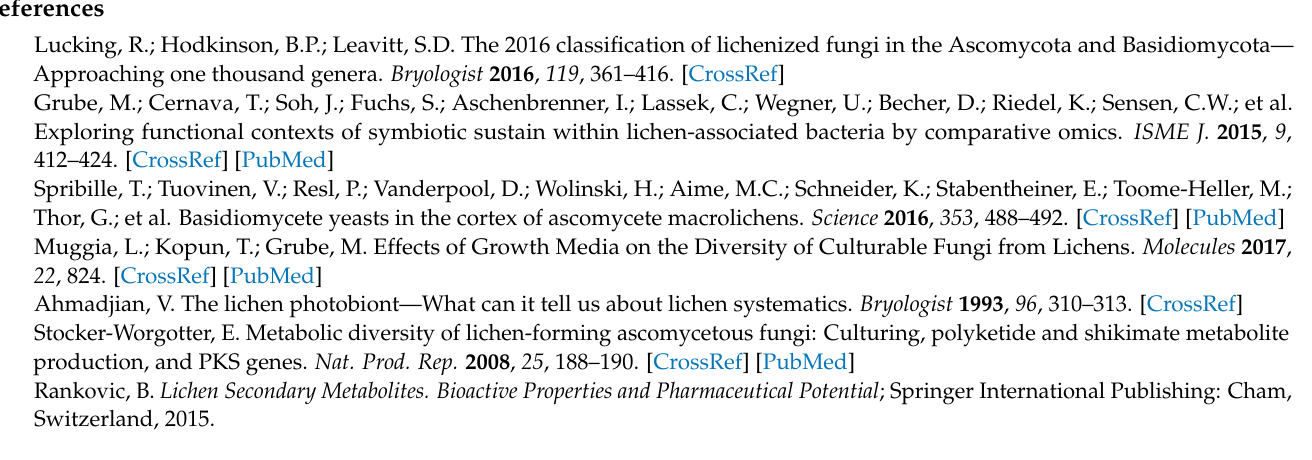
evernic acid; Figure S7. 1 H, 13 C-HSQC NMR spectrum (600 MHz, 150 MHz, DMSO-d 6 ) of evernic acid; Figure S8. 1 H, 13 C-HMBC NMR spectrum (600 MHz, 150 MHz, DMSO-d 6 ) of evernic acid; Figure S9. 1 H NMR spectrum (600 MHz, DMSO-d 6 ) of gyrophoric acid.; Figure S10. 13 C NMR spectrum (150 MHz, DMSO-d 6 ) of gyrophoric acid; Figure S11. 1 H, 13 C-HSQC NMR spectrum (600 MHz, 150 MHz, DMSO-d 6 ) of gyrophoric acid; Figure S12. 1 H, 13 C-HMBC NMR spectrum (600 MHz, 150 MHz, DMSO-d 6 ) of gyrophoric acid; Figure S13. 1 H NMR spectrum (600 MHz, CD 3 OD-d 4 ) of physodic acid; Figure S14. 13 C NMR spectrum (150 MHz, CD 3 OD-d 4 ) of physodic acid; Figure S15. 1 H, 13 C-HSQC NMR spectrum (600 MHz, 150 MHz, CD 3 OD-d 4 ) of physodic acid; Figure S16. 1 H, 13 C-HMBC NMR spectrum (600 MHz, 150 MHz, CD 3 OD-d 4 ) of physodic acid; Figure S17. 1 H NMR spectrum (600 MHz, CD 3 OD-d 4 ) of 3-hydroxyphysodic acid; Figure S18. 13 C NMR spectrum (150 MHz, CD 3 OD-d 4 ) of 3-hydroxyphysodic acid; Figure S19. 1 H, 13 C-HSQC NMR spectrum (600 MHz, 150 MHz, CD 3 OD-d 4 ) of 3-hydroxyphysodic acid; Figure S20. 1 H, 13 C-HMBC NMR spectrum (600 MHz, 150 MHz, CD 3 OD-d 4 ) of 3-hydroxyphysodic acid; Figure S21. 1 H NMR spectrum (600 MHz, DMSO-d 6 ) of physodalic acid; Figure S22. 13 C NMR spectrum (150 MHz, DMSO- d 6 ) of physodalic acid; Figure S23. 1 H, 13 C-HSQC NMR spectrum (600 MHz, 150 MHz, DMSO-d 6 ) of physodalic acid; Figure S24. 1 H, 13 C-HMBC NMR spectrum (600 MHz, 150 MHz, DMSO-d 6 ) of physodalic